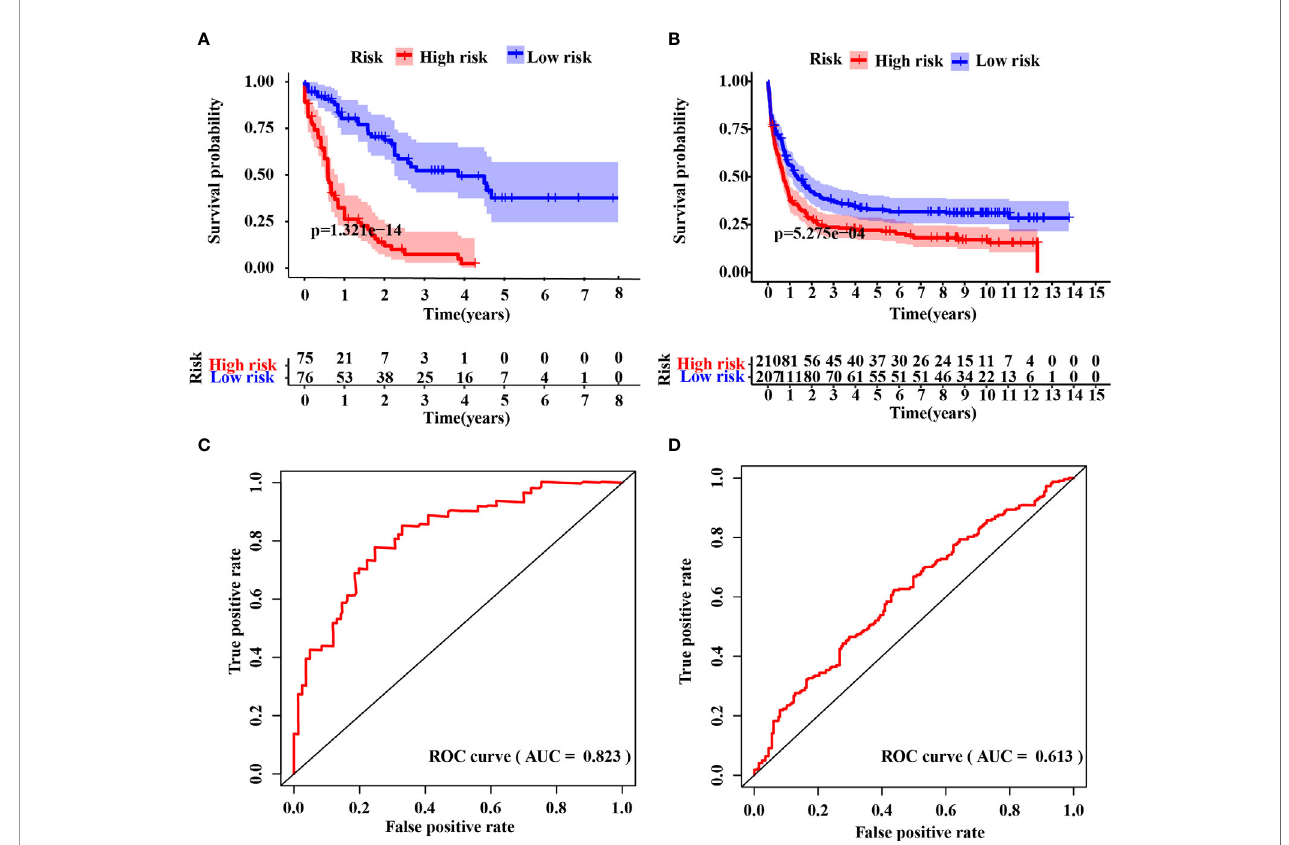
FIGURE 2 | Evaluation of the IRG signature. Kaplan – Meier curve analysis between the high- and low-risk groups in the raining (A) and validation (B) cohort, respectively. Time-dependent receiver operating characteristic (ROC) curve analysis of the immune-17 signature in the training (C) and validation (D) cohort,